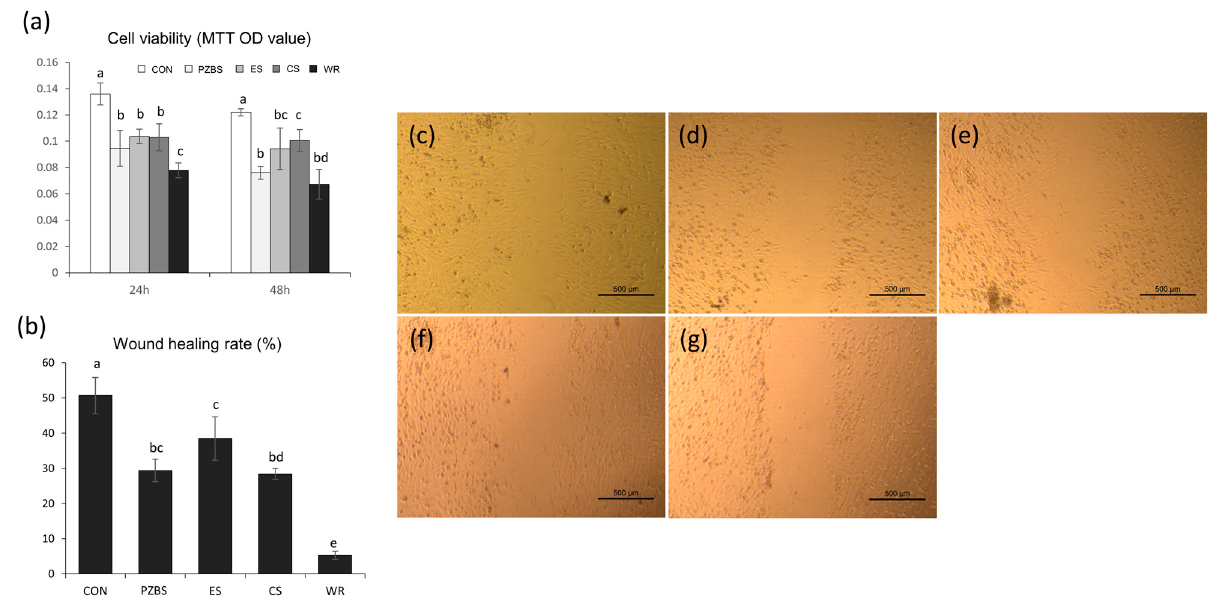
Figure 4. Cytocompatibility of PZBS and the tested root canal sealers: ( a ) Cell viability measured by the MTT assay. abcd Different letters represent significant differences ( p < 0.05). ( b ) Wound healing rate measured using the cell migration assay. abcde Different letters represent significant differences ( p < 0.05). ( c – g ) Representative images of wound healing percentage based on the cell migration assay: ( c ) Control; ( d ) PZBS; ( e ) EndosealTCS; ( f ) Ceraseal; ( g ) Well-Root. CON: control, PZBS: pozzolan-based bioceramic sealer, ES: EndosealTCS, CS: Ceraseal, WR: Well-Root.